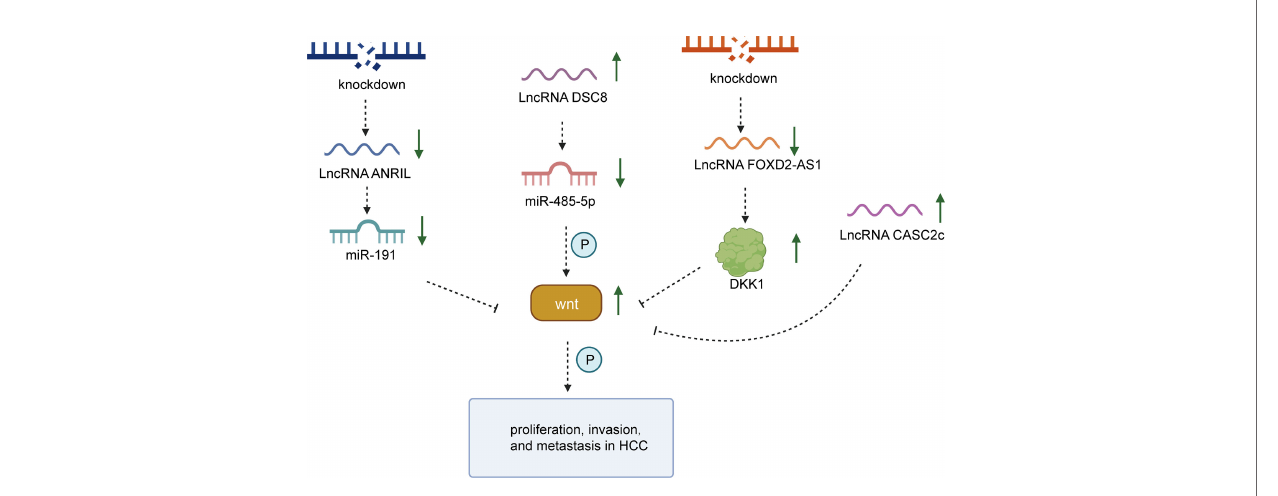
FIGURE 3 | The speci fi c mechanism of lncRNAs and the Wnt/ b -catenin pathway in the proliferation, invasion and migration processes of HCC. LncRNA DSCR8 could sponge miR-485-5p to trigger Wnt/ b -catenin signaling. Silencing of lncRNA ANRIL could block the progression of HCC by downregulating miRNA-191 to inhibit Wnt/ b -catenin. Knockdown of lncRNA FOXD2-AS1 exerts a suppressive effect on the development of HCC via the inhibition of Wnt/ b -catenin. Upregulation of CASC2c attenuates the activation of Wnt/ b